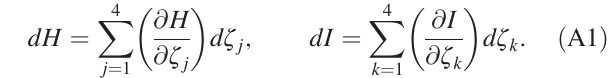
FIG. 21. Distance (42) from the origin to the innermost unstable critical structure in the plane p The origin itself is unstable when j τ j > 1 = 2 . When τ ¼ 0 , the dynamical system described by (9) is linear and stable, with d ð τ Þ ¼ ∞